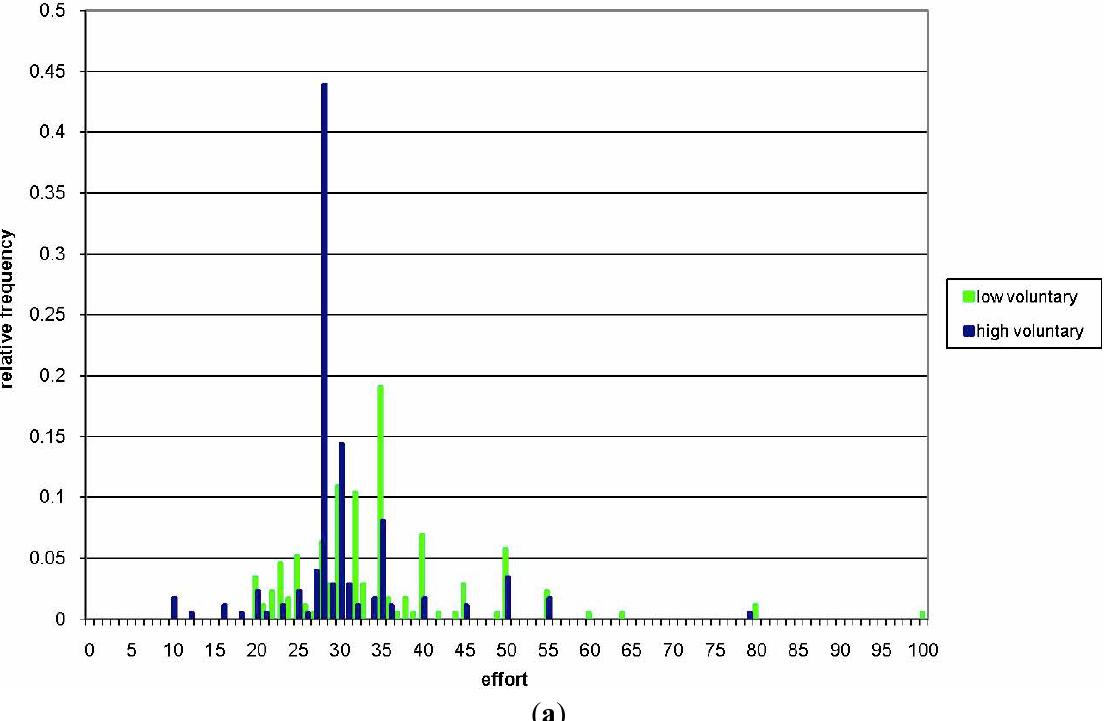
Figure 2. ( a ) Density of team effort in the VOLUNTARY ASYM treatment; ( b ) Density of team effort in the ENFORCED ASYM